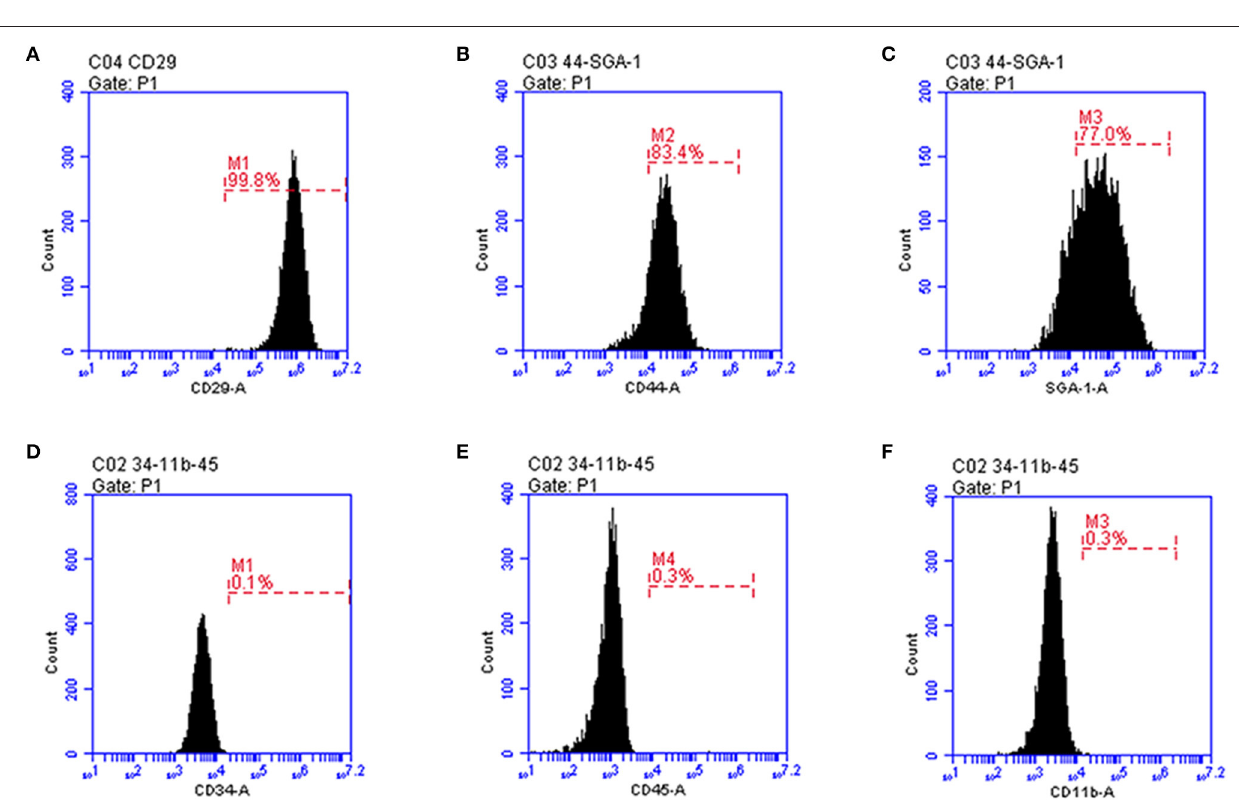
( P < 0.05; Figure 3A ) and 14 d ( P < 0.05; Figure 3A ), on string test at 7 d ( P < 0.05; Figure 3C ), and on global score at 3 d ( P